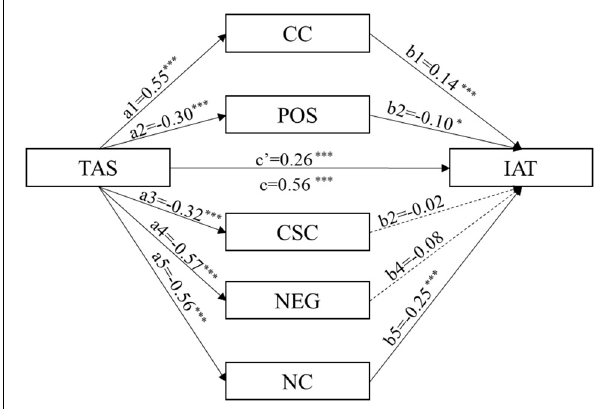
FIGURE 2 | Mediation model of alexithymia, Internet addiction, and metacognition with its dimensions. TAS, Toronto Alexithymia Scale; CC, cognitive confidence; POS, positive beliefs about worry; CSC, cognitive self-consciousness; NEG, negative beliefs about uncontrollability and danger of worry; NC, need to control thoughts; IAT, Internet addiction test; ∗ p < 0.05, ∗∗∗ p < 0.001; the continuous lines mean that the path coefficient between the variables is significant. The dotted lines mean that the path coefficient between the variables is not